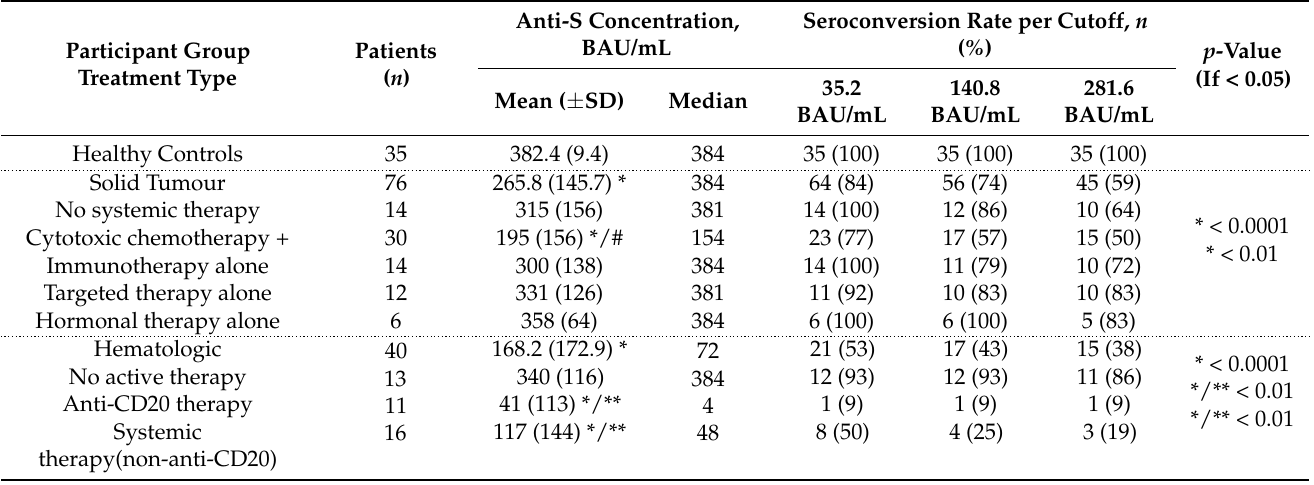
Table 2. Anti-spike Antibody Concentration and Seroconversion Rates in Solid Tumour and Hemato- logic Patients following Two Doses of COVID-19 Vaccine, According to Treatment